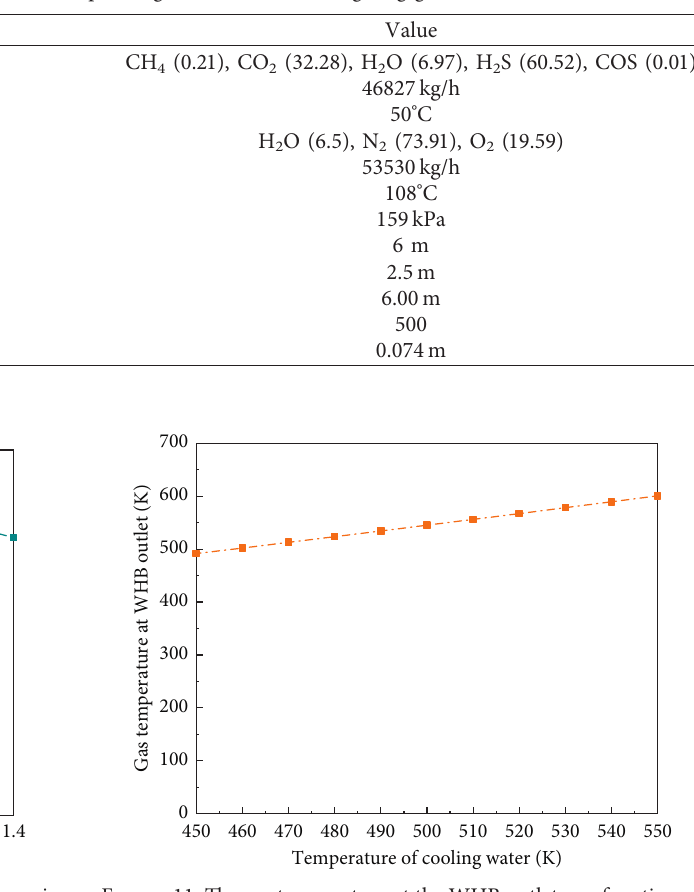
Figure 11: The gas temperature at the WHB outlet as a function of the temperature of cooling water.